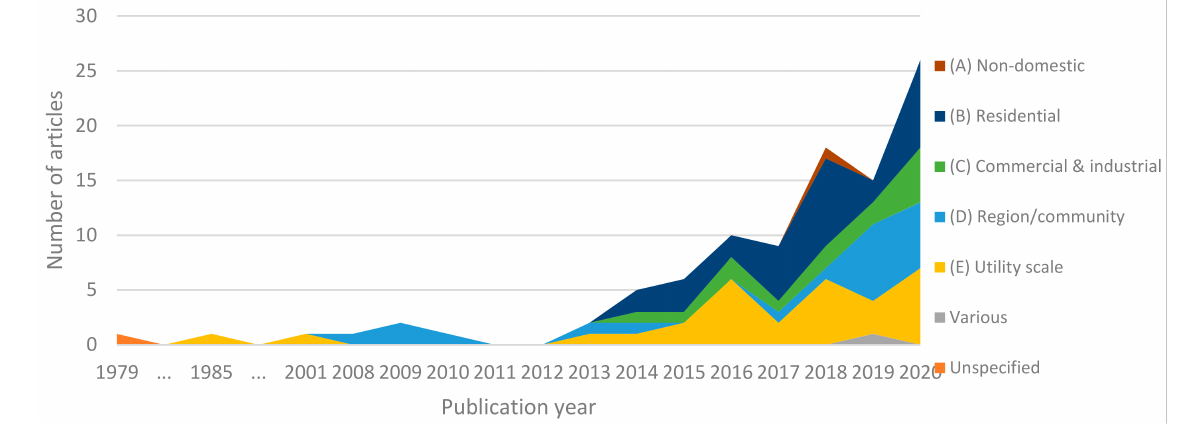
Figure 9. Distribution of studies over the years based on the unit or the